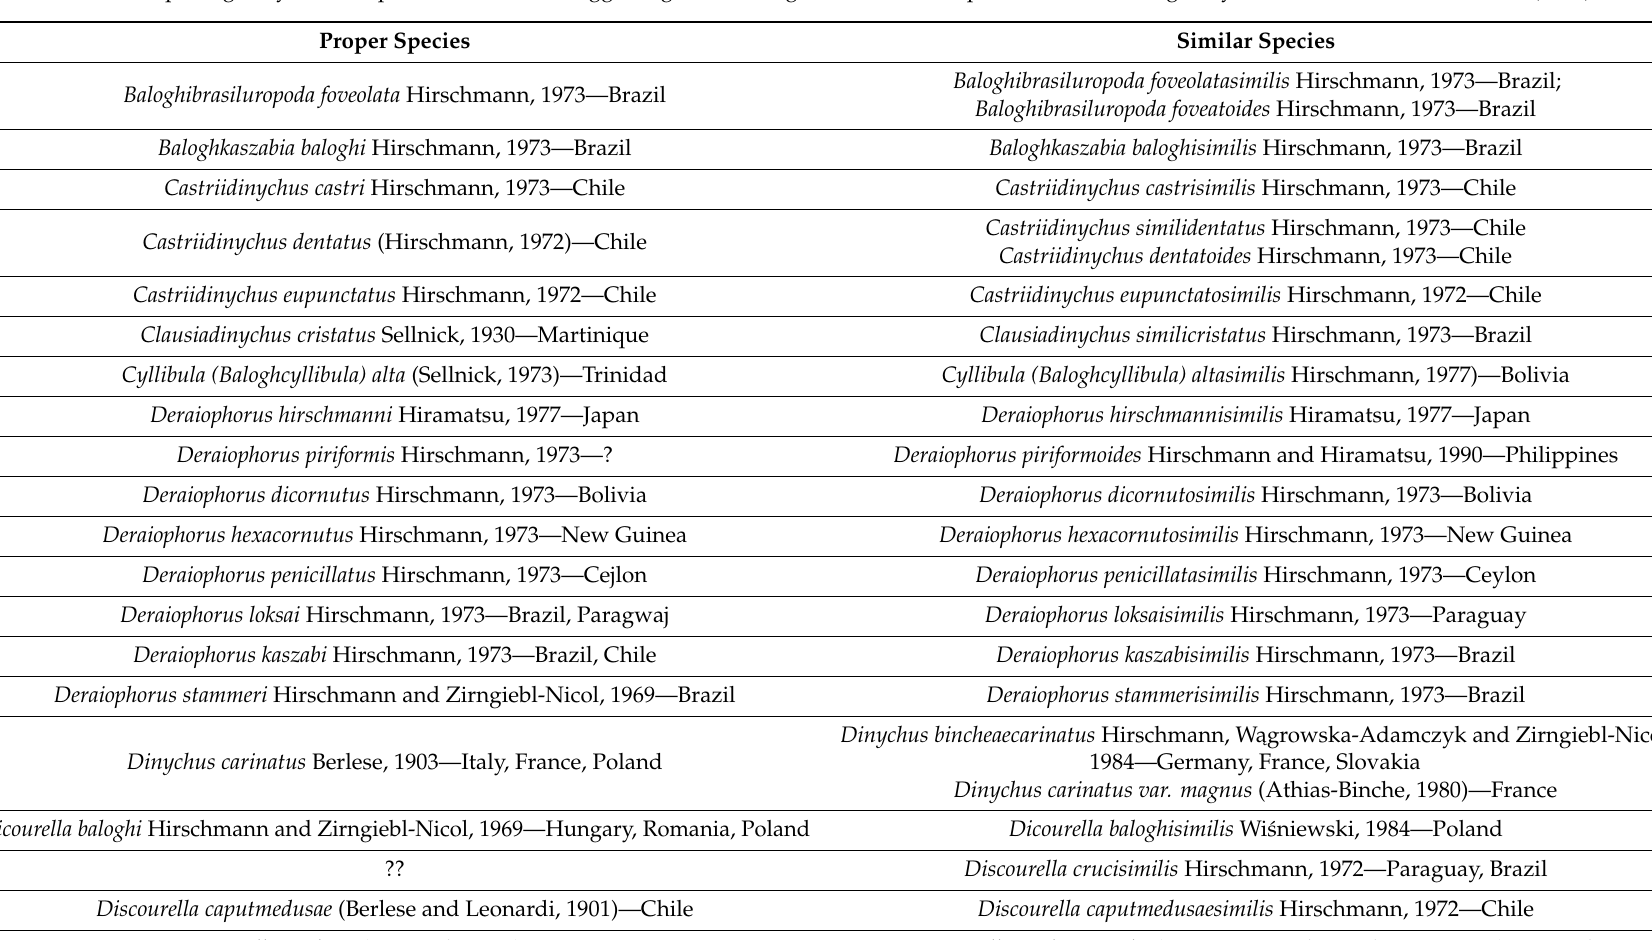
Table 1. Morphologically similar species with names suggesting their close genetic relationship listed in the catalogue by Wi´sniewski and Hirschmann (1993) 1 . Proper